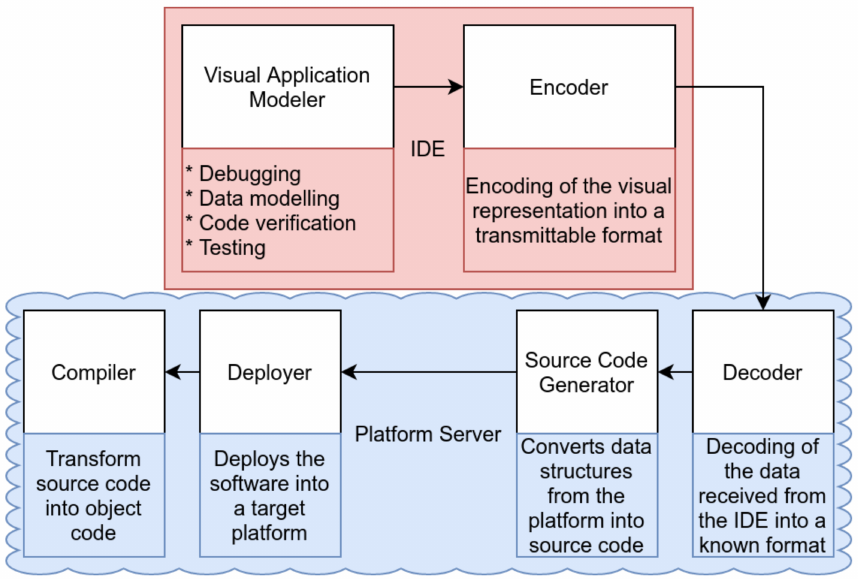
Figure 1. The general architecture of low-code